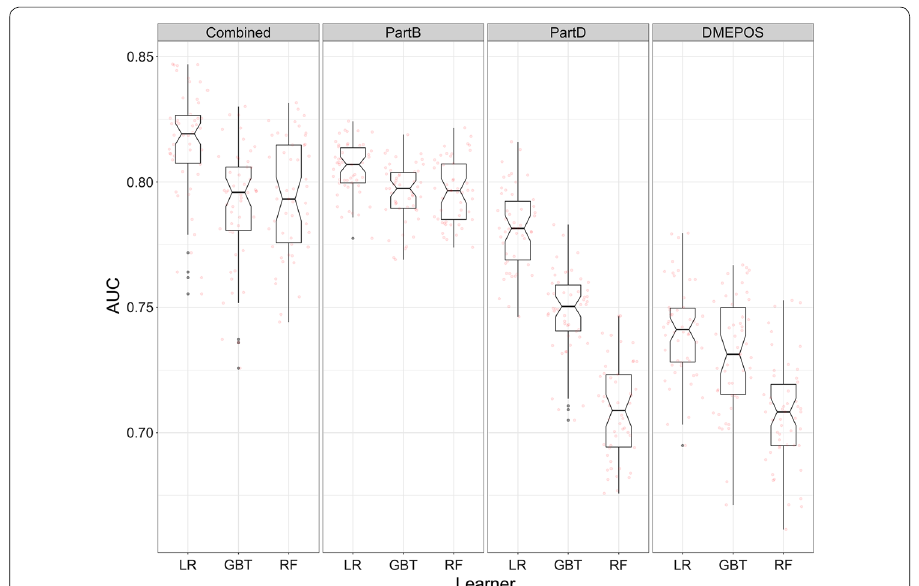
Fig. 1 AUC values for 10 runs of fivefold cross-validation for each learner and dataset combination